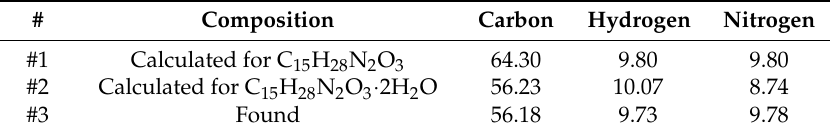
Table 2. Comparison of the CHN elemental analysis results of the amidoacidified copolymer with calculated